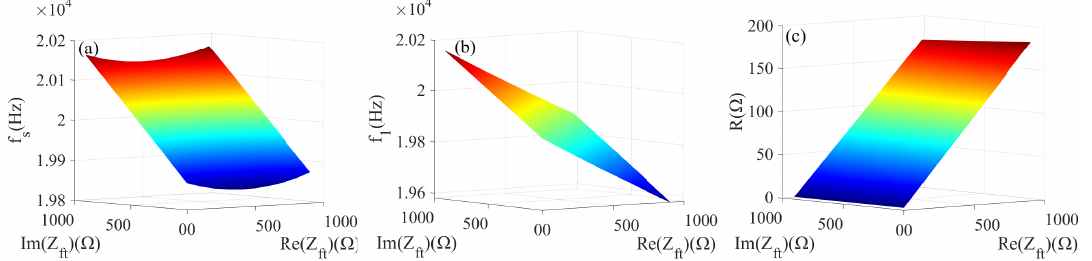
Figure 10. ( a ) f s and Z ft ; ( b ) f 1 and Z ft ; ( c ) R and Z ft .